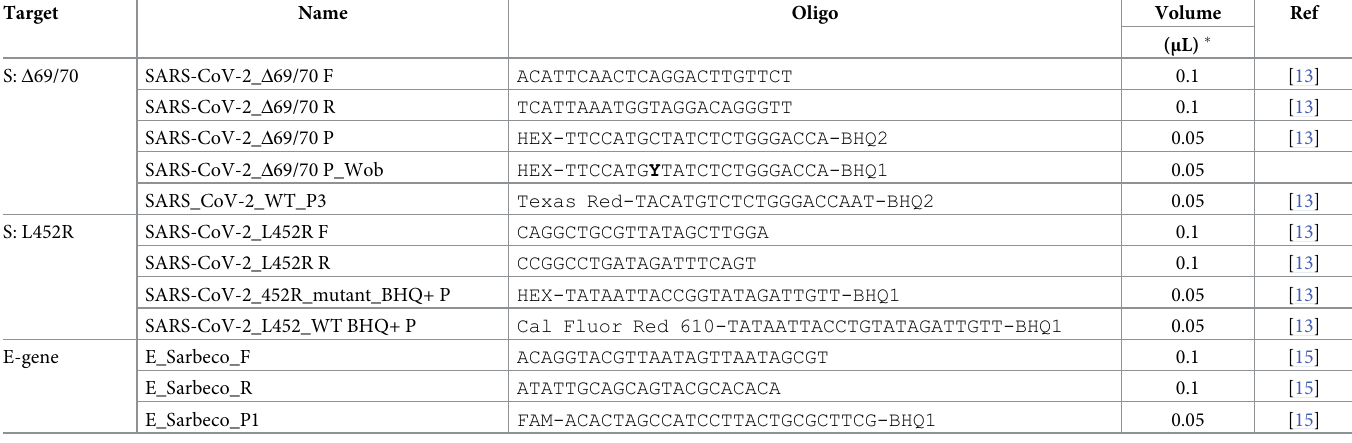
Table 1. Primers and probe sequences and relative concentration used in RT-qPCRs.